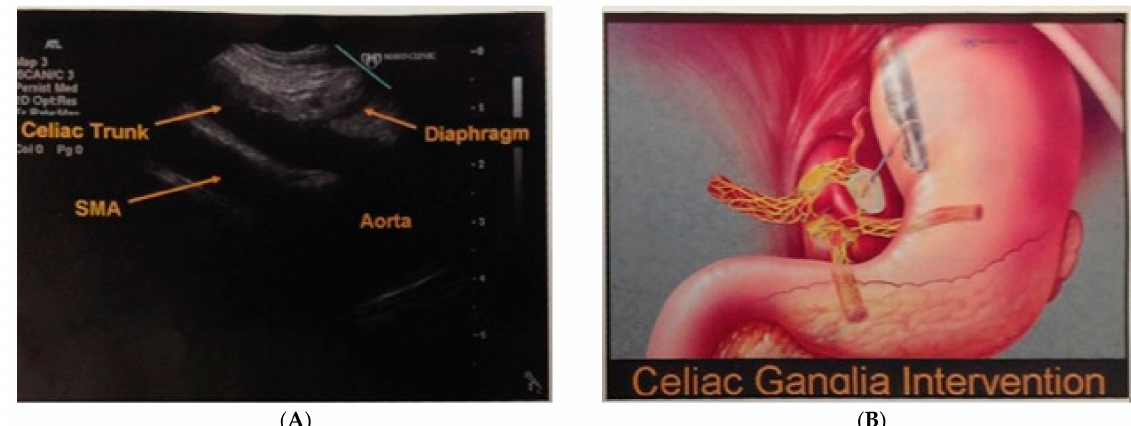
Figure 3. Endoscopic ultrasound (EUS)-guided celiac plexus neurolysis. ( A ) EUS showing the anatomic relationship between the diaphragm, aorta, celiac trunk, and the superior mesenteric artery. ( B ) Demonstration of EUS guided injection of the celiac ganglion. (Reproduced from McCallum et al. [4] with permission from Practical